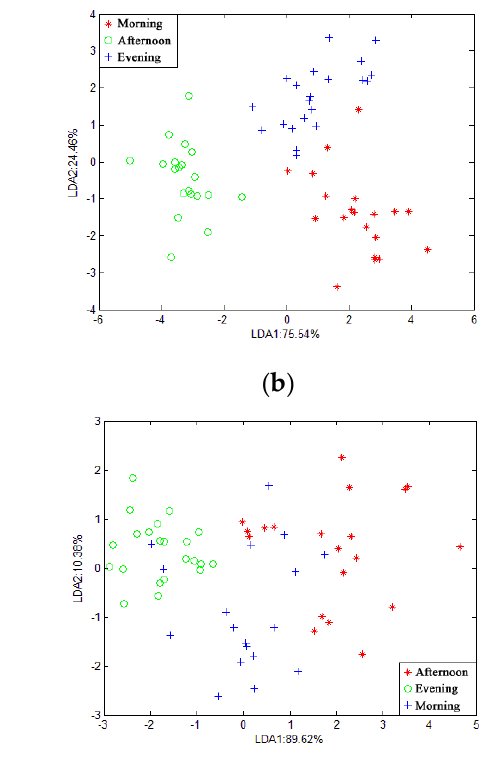
Figure 5. LDA chart of different time at the same position in pig house with features of average values: ( a ) pregnan- cy-exhaust; ( b ) pregnancy-middle; ( c ) nursery-middle; ( d ) nursery-window.